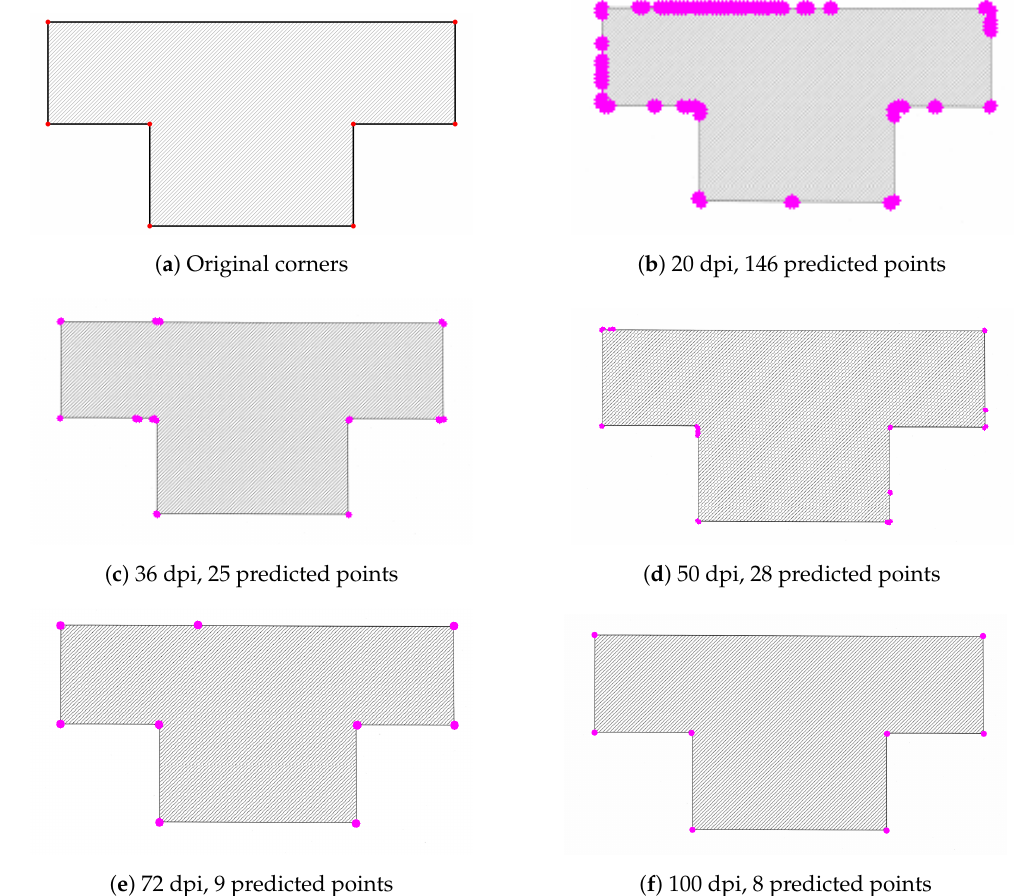
Figure 3. Detection of corners determined from the resolution of scanned cross-section; ( a ) shows the corners as designed by the CAD model; ( b – f ) show the corner estimation at various resolutions.